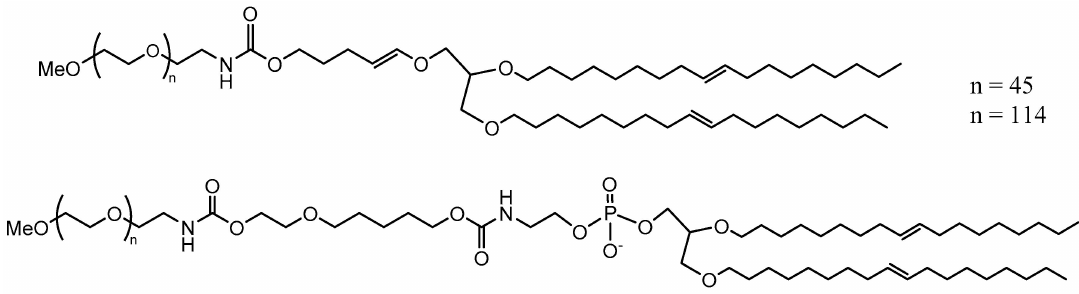
Figure 10. Vinyl-ether-based lipids tested by Thompson and co-workers